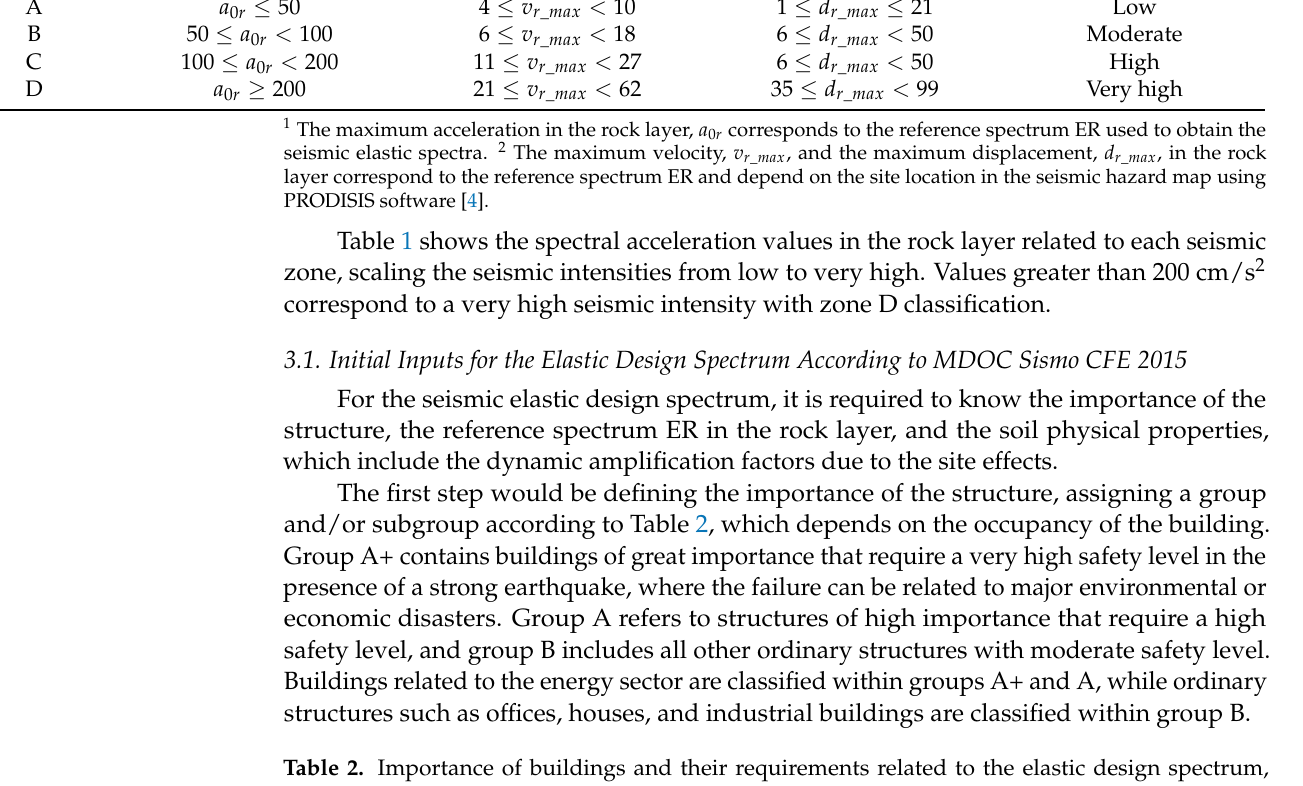
Table 2. Importance of buildings and their requirements related to the elastic design